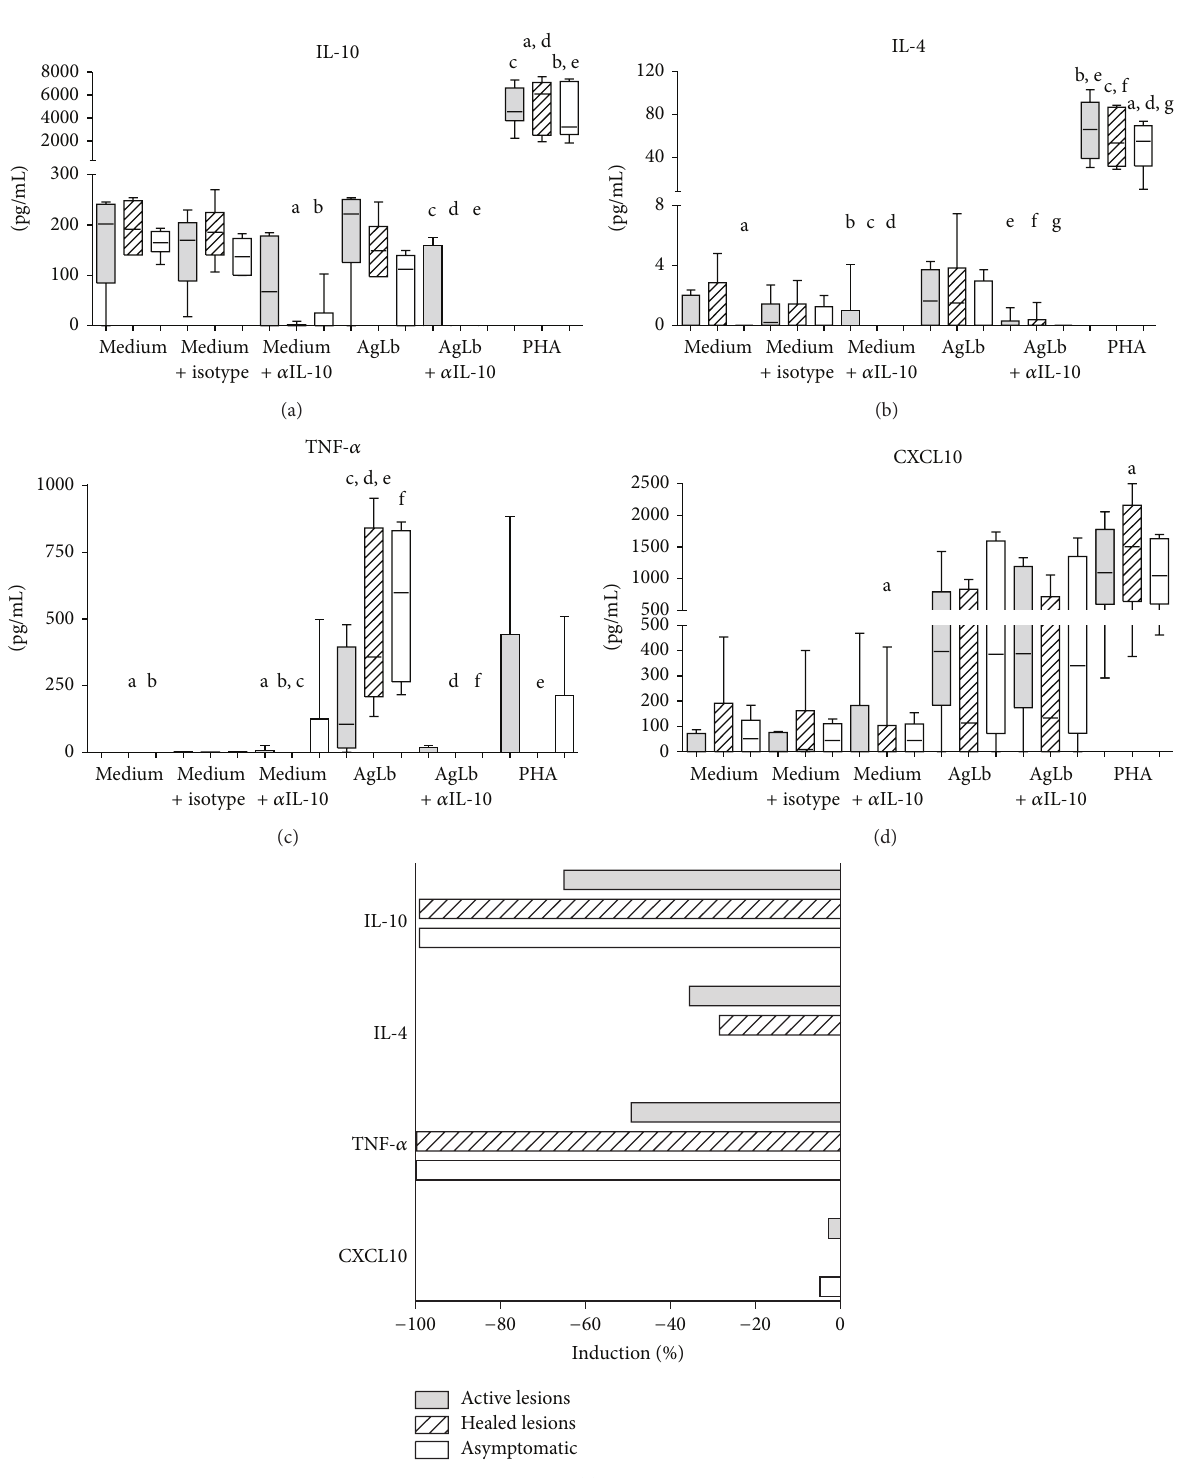
Figure 1: Modulatory effects of in vitro IL-10 blockade over T cell response in patients with cutaneous leishmaniasis. Cytokines IL-10, IL- 4, TNF- 𝛼 , and chemokine CXCL10 produced by PBMC were measured by ELISA. Cells were cultured for 24 h in the presence of 5 𝜇 g/mL L. braziliensis antigens alone or in combination with 5 𝜇 g/mL anti-human IL-10 mAb. Patients were grouped according to the presence of active lesions ( 𝑛 = 6 ), healed lesions ( 𝑛 = 6 ), or lack of any disease history ( 𝑛 = 6 ). (a)–(d) Levels of each cytokine production are plotted. The horizontal line represents the median, the bar 25th–75th percentiles, and the vertical line the 10th–90th percentiles. Equal letters mean Kruskal-Wallis test, 𝑃 < 0.05 , and post hoc Dunn test statistically significant. (e) Percentage of induction in the production of each cytokine and chemokine by IL-10 blockade was evaluated considering {[( AgLb +𝛼 IL- 10)− AgLb ]/ AgLb }∗100 . Bars indicate median inhibition values for each group. ∗ 𝑃 < 0.05